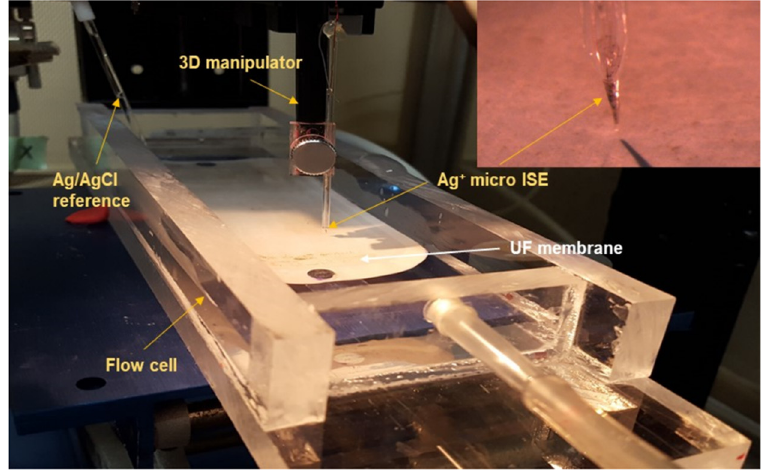
Figure 2. Silver (Ag) microprofile measurement setup (inset: closeup of Ag + micro-ion-selective electrode (micro-ISE)).